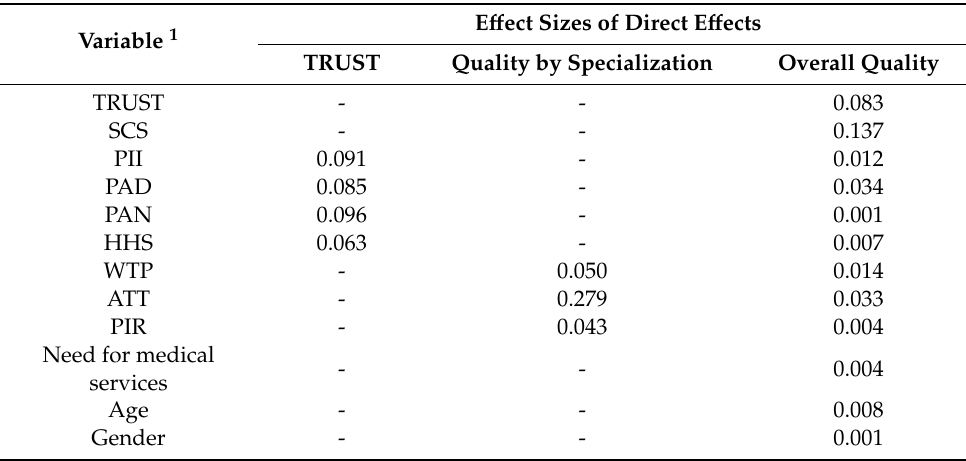
Table 6. E ff ect sizes of direct e ff ects.